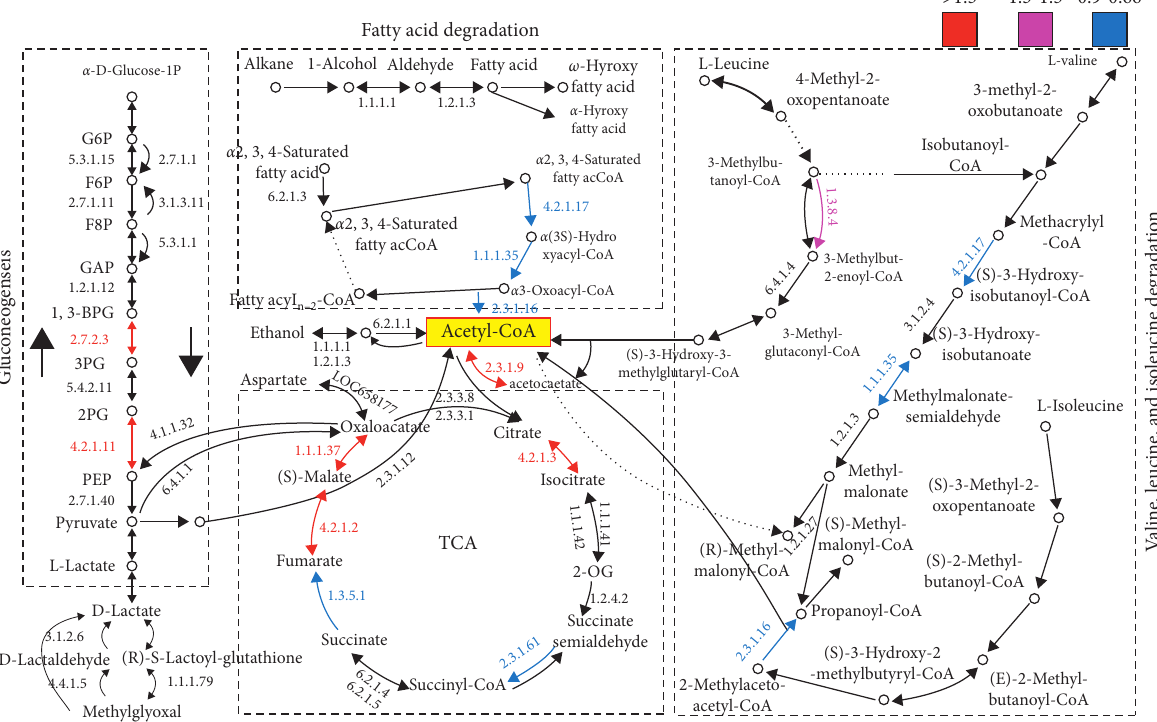
Figure 4: The metabolism pathway of the main energy sources. Different colors indicate the ranges of the fold change (cultivated at 4 ° C/ cultivated at 30 ° C)